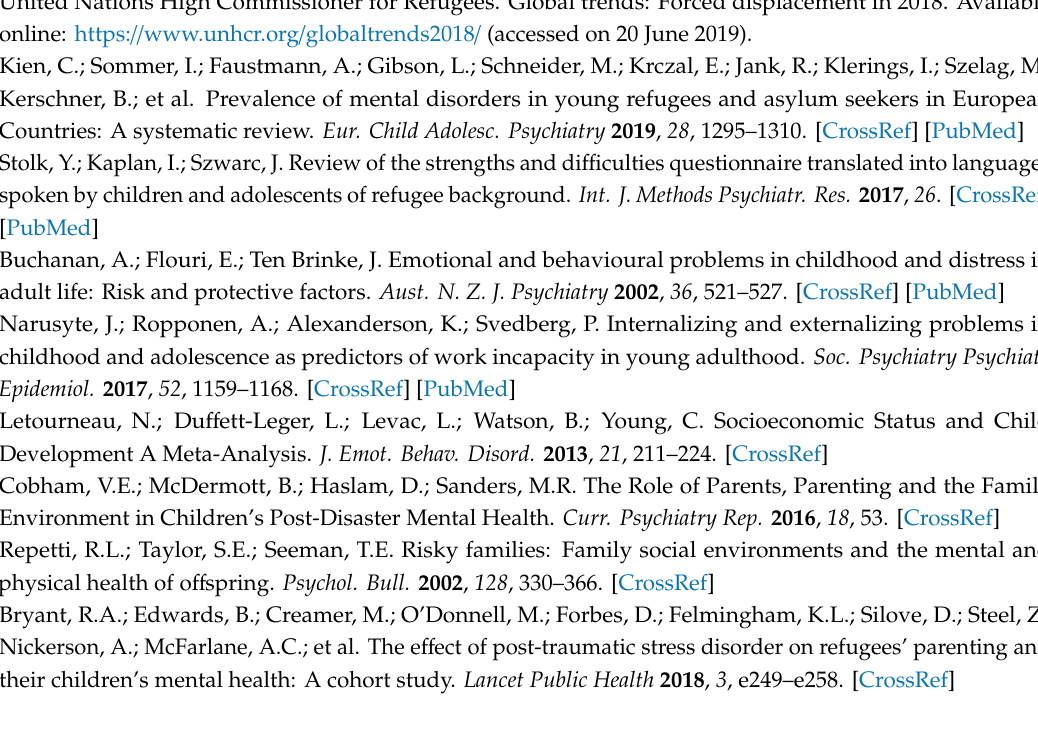
Figure A2. Extended FSM including primary caregivers’ levels of acculturation. Note . * p < 0.05, ** p < 0.01, *** p < 0.001. Coe ffi cients are standardized path coe ffi cients. The solid lines represent significant paths ( p < 0.05). The dashed lines represent non-significant paths. Children’s age, gender, physical health, overall achievement at school, experiences of pre-migration trauma, and primary caregivers’ education are included as covariates. Model fitting indices: 2 (437) = 759.834, p < 0.001, CFI = 0.938, TLI = 0.926, RMSEA = 0.034, SRMR =